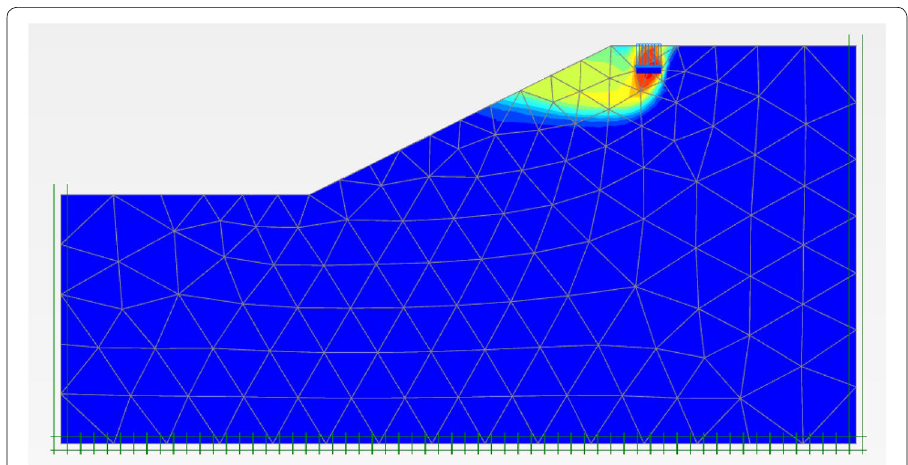
Fig. 5 Atypical finite element model with mesh and boundary